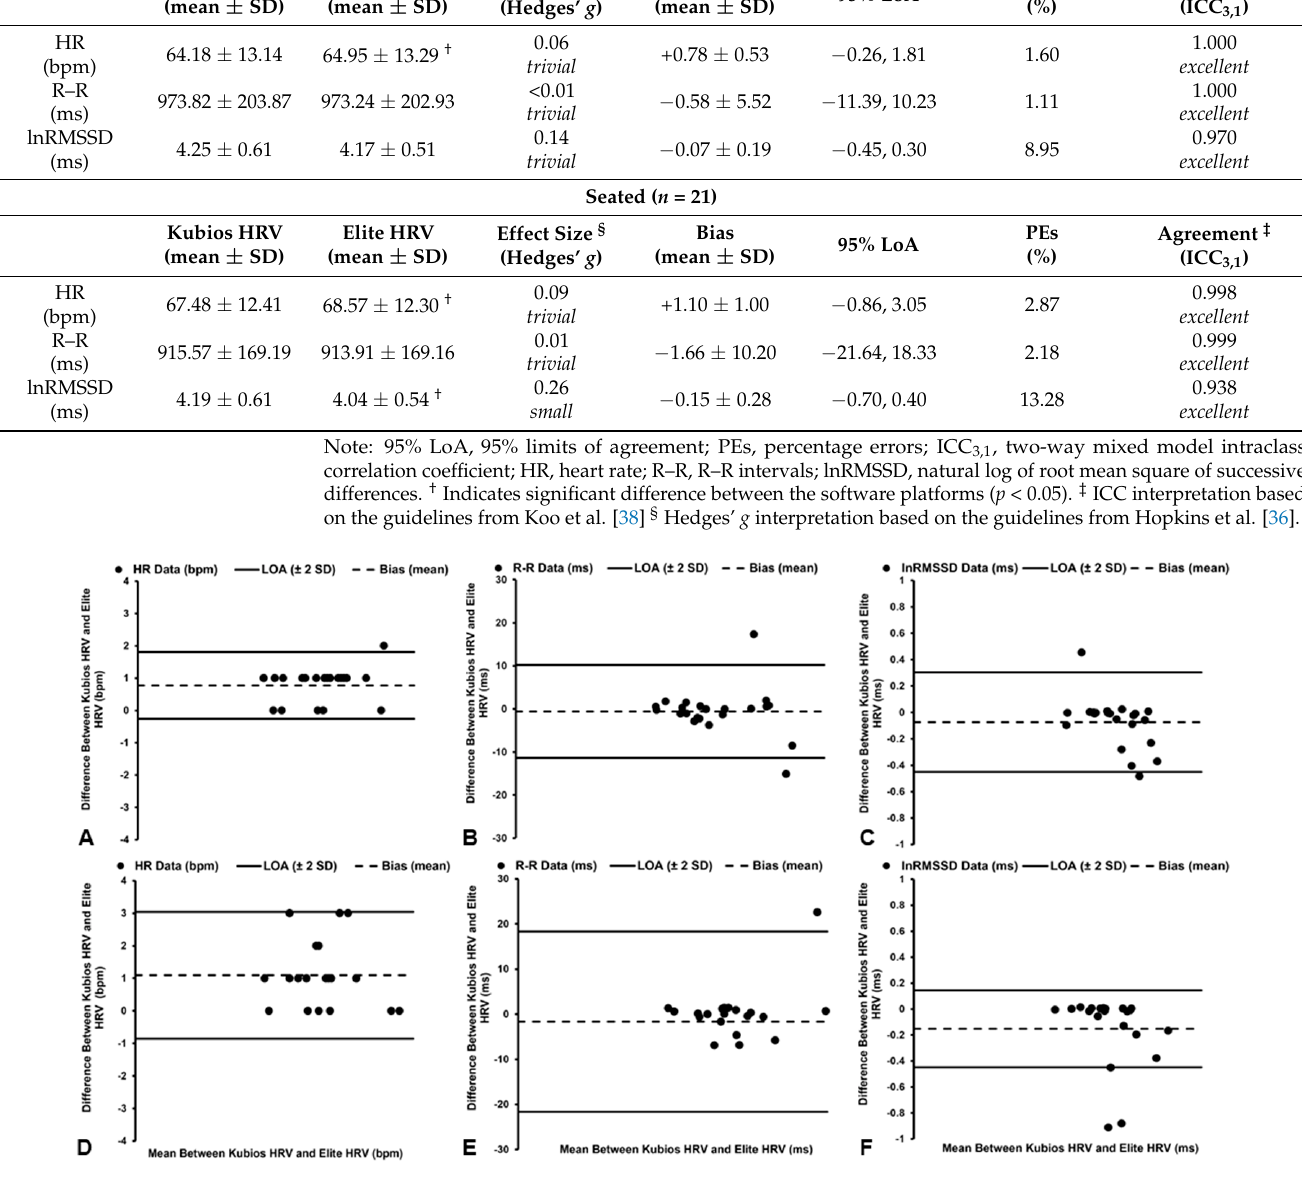
Figure 2. Bland–Altman plots demonstrating the mean bias and limits of agreement (LoA) of heart rate (HR, A ), R–R interval ( B ), and natural log of root mean square of successive differences (lnRMSSD, C ) data in the supine position and the mean bias and limits of agreement (LoA) of HR ( D ), R–R interval ( E ), and lnRMSSD ( F ) data in seated position when utilizing No artifact correction.